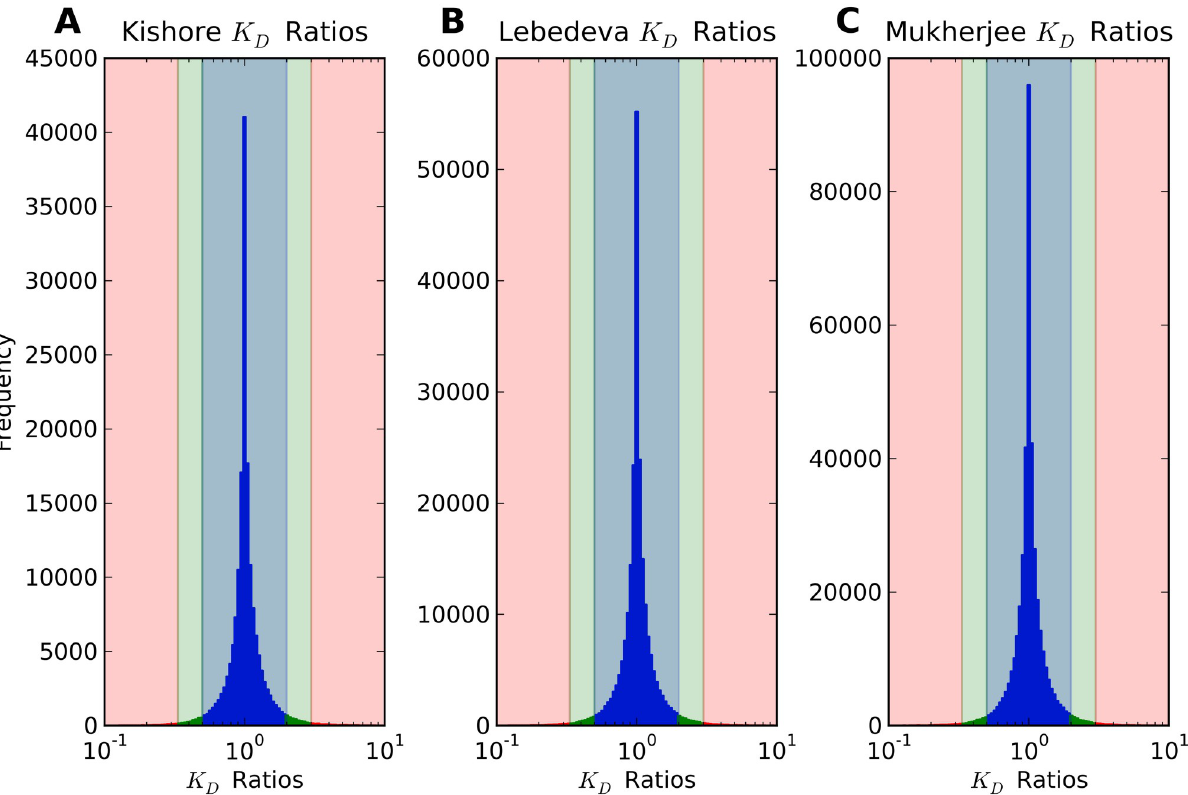
Fig 3. K D ratios of HuR binding to 201 nucleotide sequences with and without SNPs. Histograms for the affinity ratios using (A) Kishore [30] HuR binding sites, (B) Lebedeva [31] HuR binding sites, and (C) Mukherjee [32] HuR binding sites. Affinity ratios are defined to be the dissociation constant K D for HuR binding to the alternate allele of the SNP over the dissociation constant K D for HuR binding to the reference sequence. Ratios larger than threefold are shown in red, ratios between two- and threefold are shown in green, and ratios less than twofold are shown in blue.